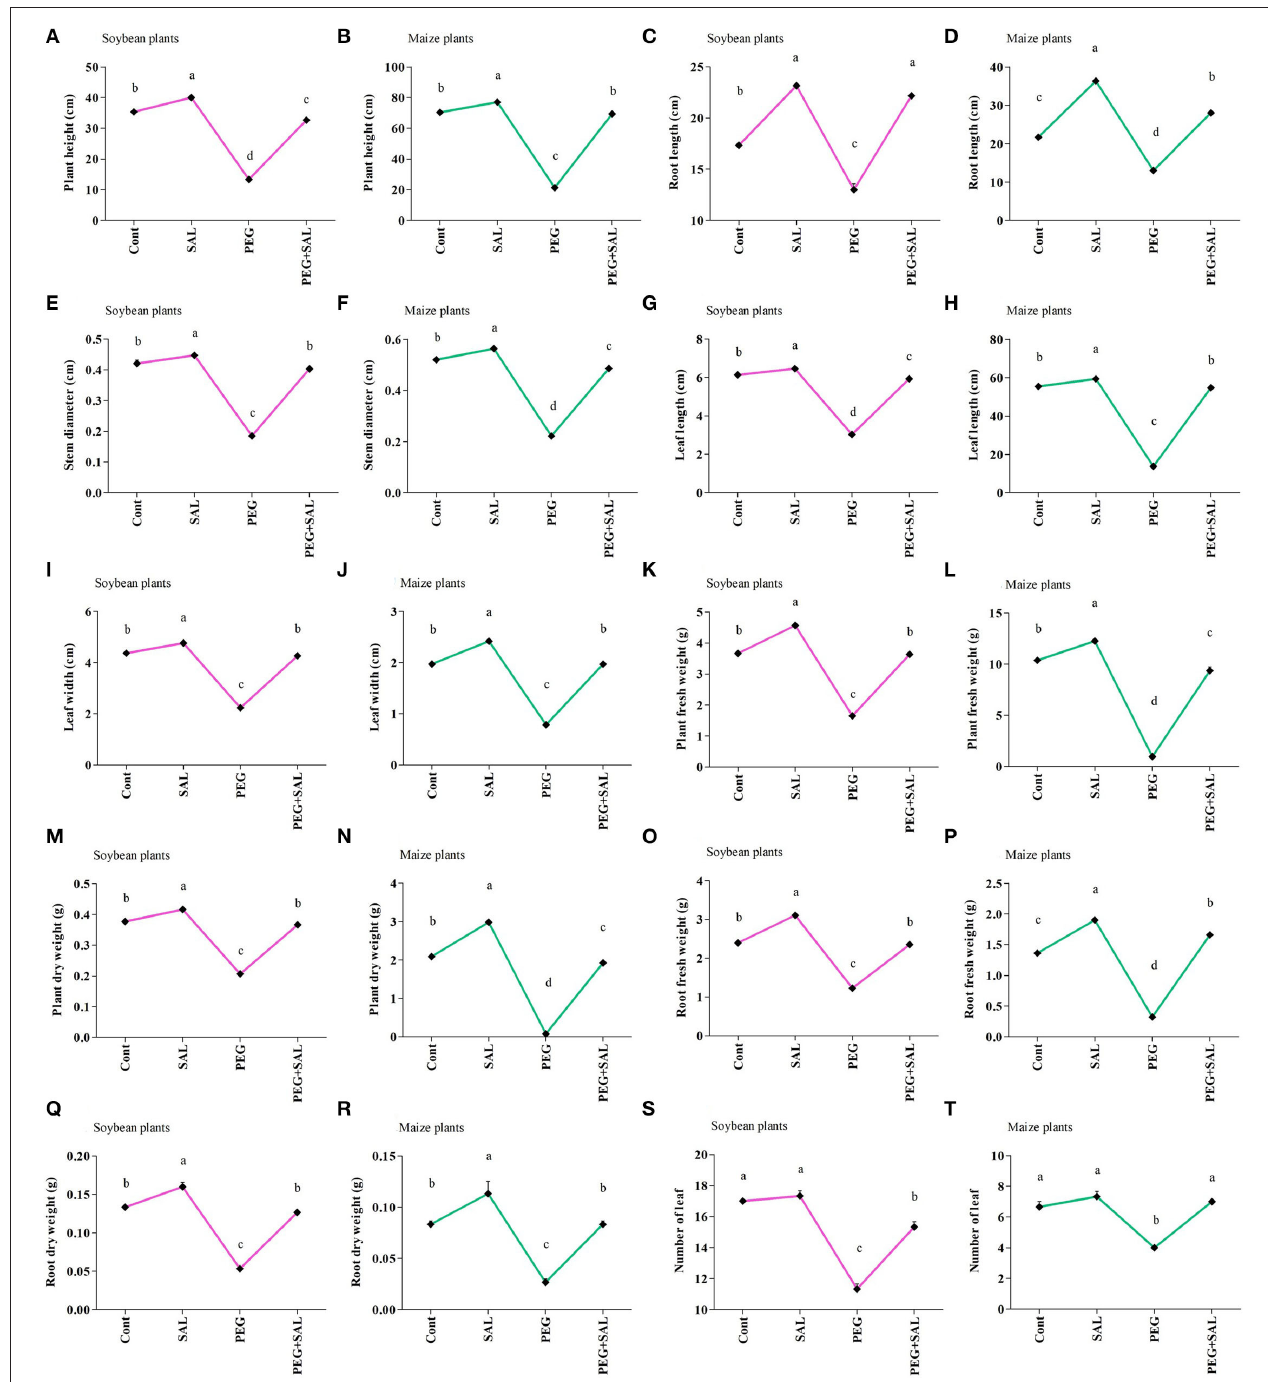
FIGURE 2 | Impact of salvianolic acid on soybean and maize plant growth parameters under normal and stress conditions 8 days post-treatment (A–T) . Treatments: Cont (control), SAL (0.1 µ M salvianolic acid), SAL (1 µ M salvianolic acid), PEG (25% polyethylene glycol), SAL (0.1 µ M salvianolic acid) + PEG (25% polyethylene glycol), and SAL (1 µ M salvianolic acid) + PEG (25% polyethylene glycol). Values show the mean ± SE ( n = 6) and significant differences at p < 0.05 (Tukey’s test). Bars with different lowercase letters are significantly different from each other. osmotic stress conditions when compared to the stressed and maize plants (7.56 and 27.28%, correspondingly). On control plants, and the difference was significant ( p < 0.05; the other hand, SAL application contributed to an 8.02% Figures 3A,B (soybean) and 15.75% (maize) promotion in TCC under